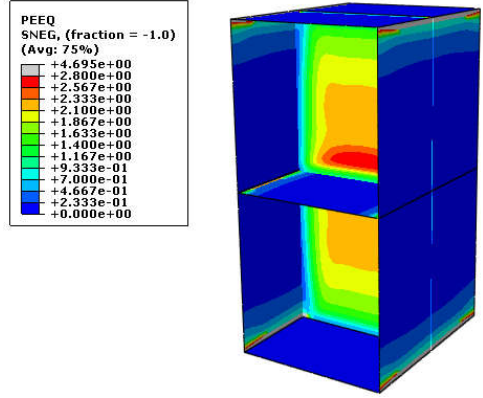
Figure 22. The plastic strain in this sample.